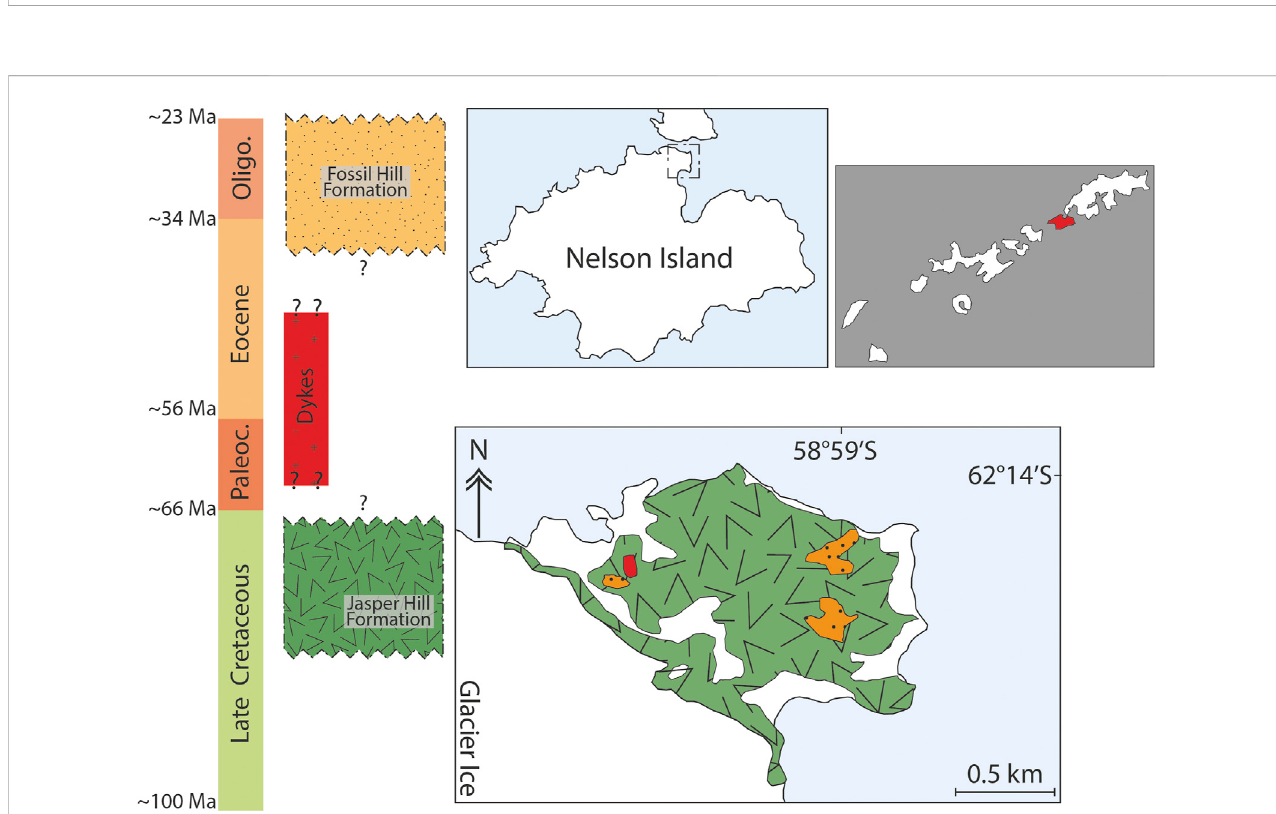
FIGURE 11 Geological map of northern Nelson Island, modi fi ed from Li et al. (1996).